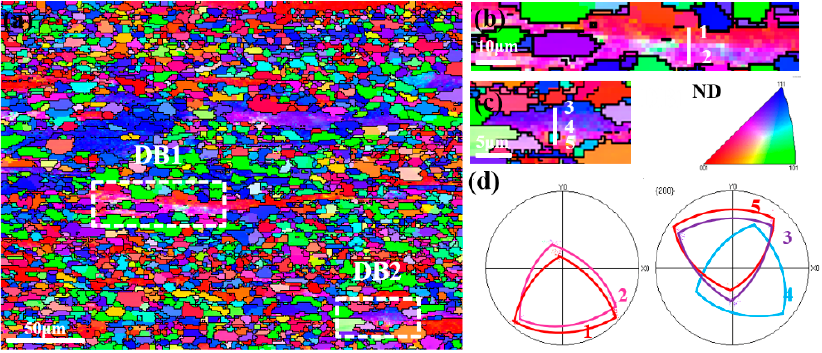
Figure 9. Recrystallization of a deformed band at 700 °C: ( a ) inverse pole figure (IPF), ( b ) DB1, ( c ) DB2 and ( d ) pole figures of DB1 and DB2.